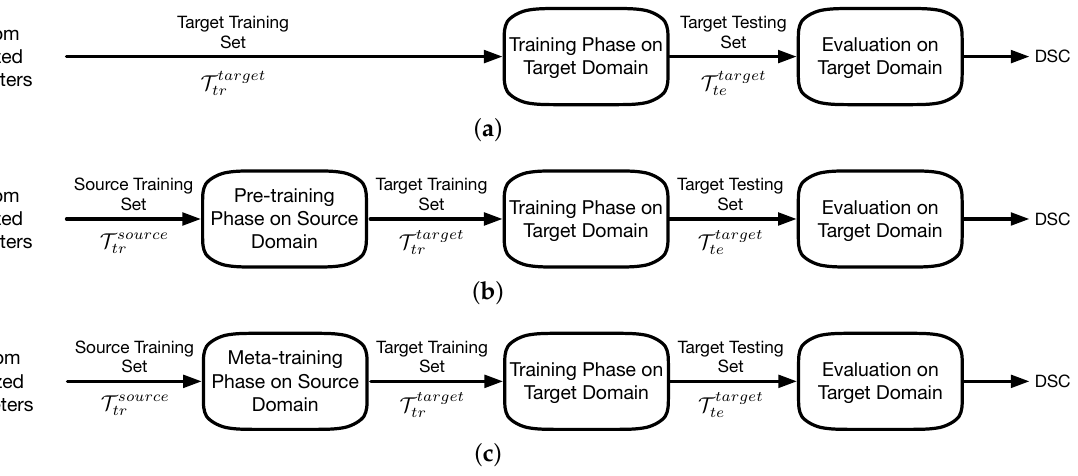
Figure 5. The three pipelines. ( a ) Pipeline I; ( b ) pipeline II; ( c ) pipeline